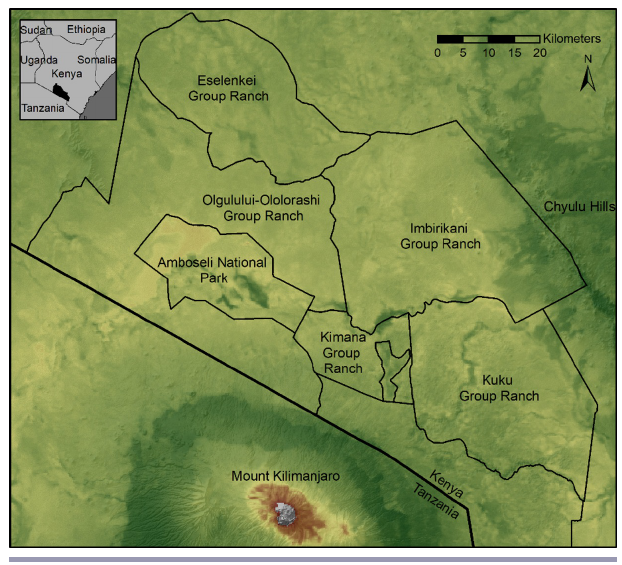
Fig. 1 . Map of the three group ranches (Imbirikani, Eselenkei, and Olgulului-Ololorashi) studied, Amboseli National Park, and surrounding